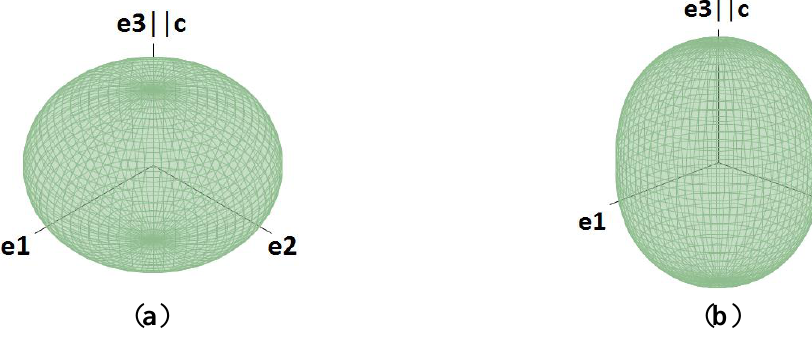
Figure 2. Temperature dependency of α 11 and α 33 . The figure has been produced from the numerical output of Thermal Expansion Visualizing (TEV) using the program Gnuplot [19].